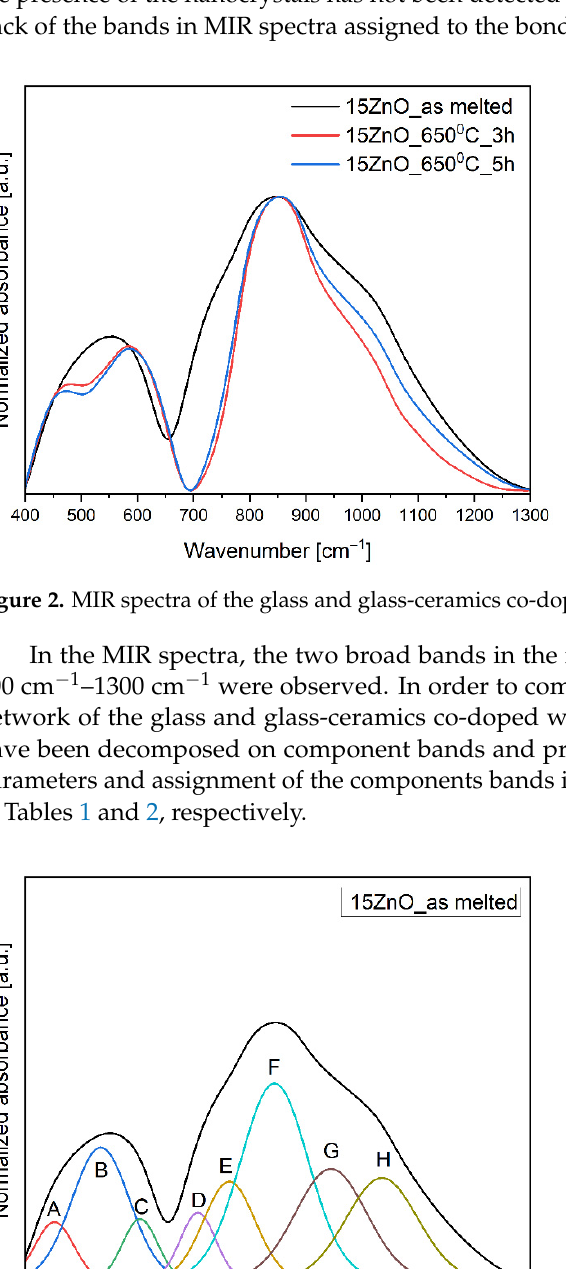
Figure 4. MIR spectrum of the 15ZnO glass-ceramics sample obtained after HT@650C for ( a ) 3 h, ( b ) 5 h.